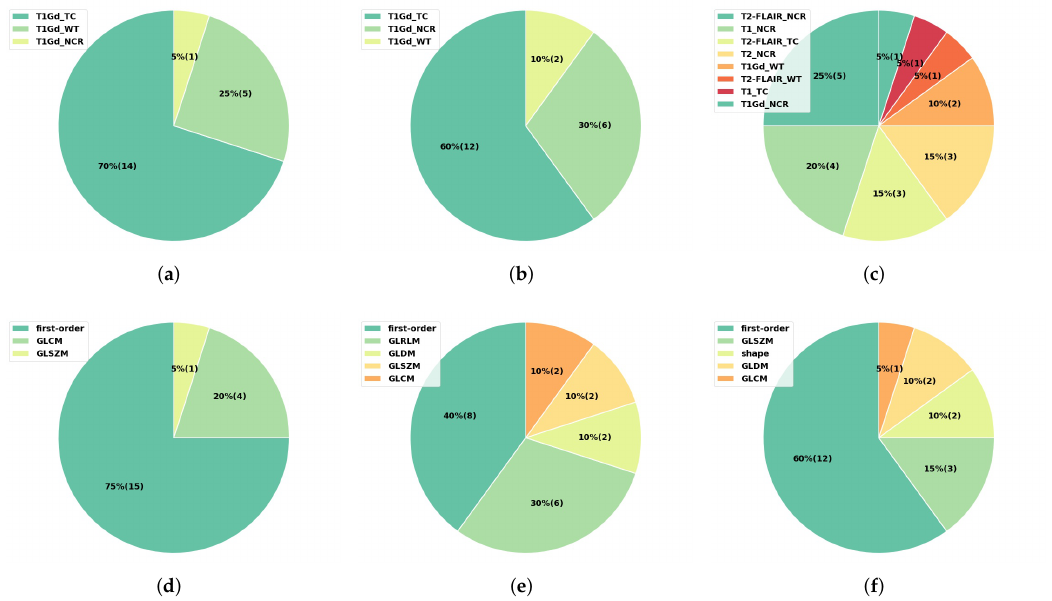
Figure 14. Statistics of the first 20 radiomic features with the highest average feature importance calculated by ANOVA F-value and averaged on 51 random seeds. The first row shows the statistics of the MRI sequences and tumor subregions ( a ) for predicting tumor grade, ( b ) for predicting IDH mutation status, and ( c ) for predicting 1p/19q codeletion status. The second row shows the statistics of the feature types ( d ) for predicting tumor grade, ( e ) for predicting IDH mutation status, and ( f ) for predicting the 1p/19q codeletion status, respectively. The values in the brackets represent the number of